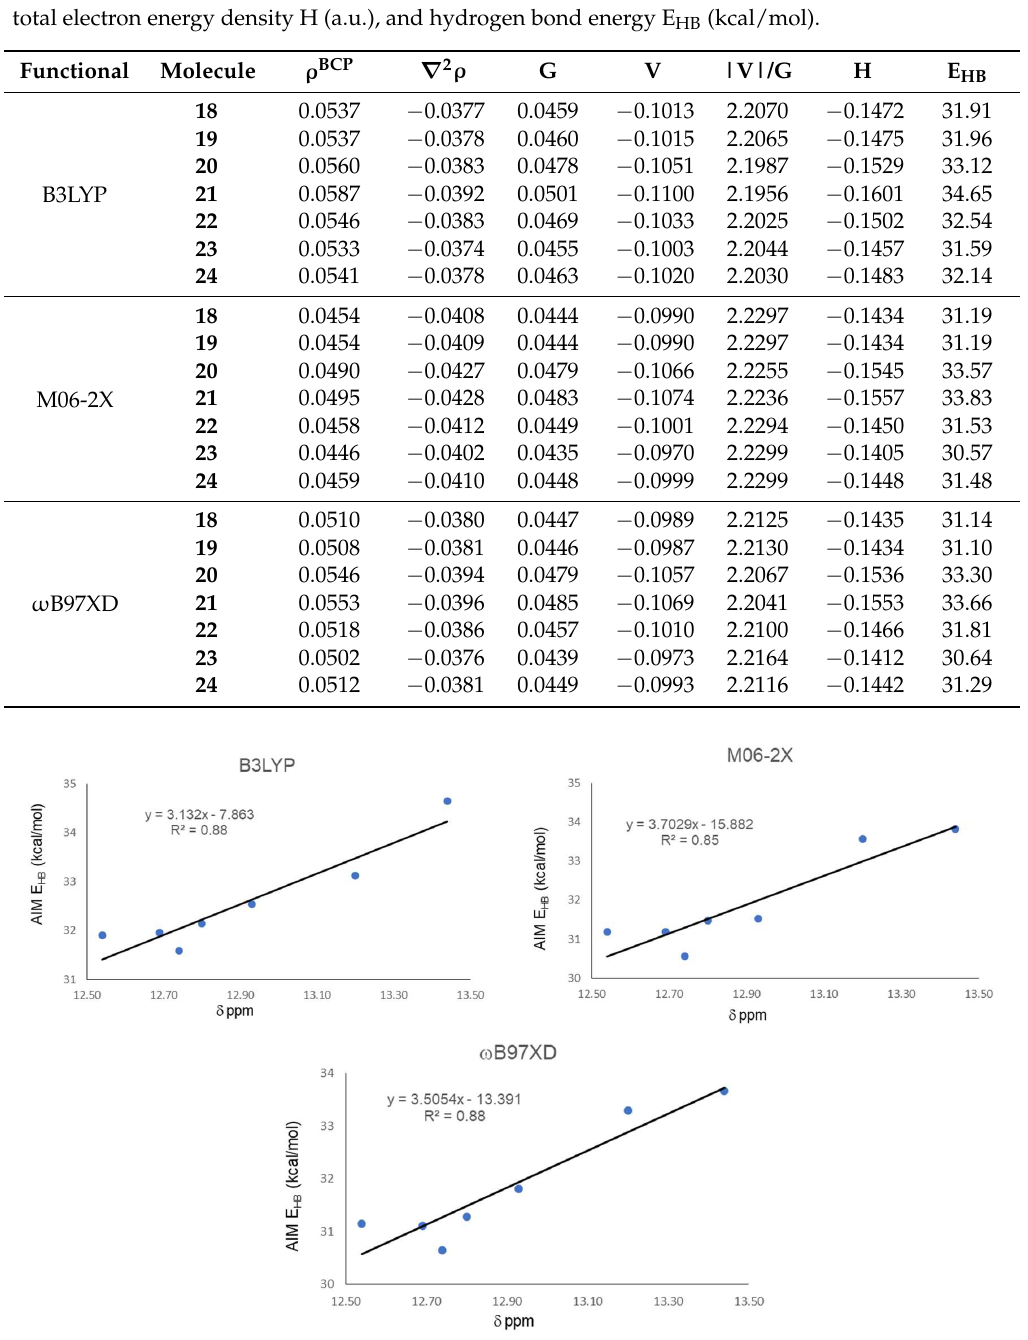
Table 4. Atoms-in-molecule parameters for IHB of 18 – 24 . Electron density at the critical point ρ BCP